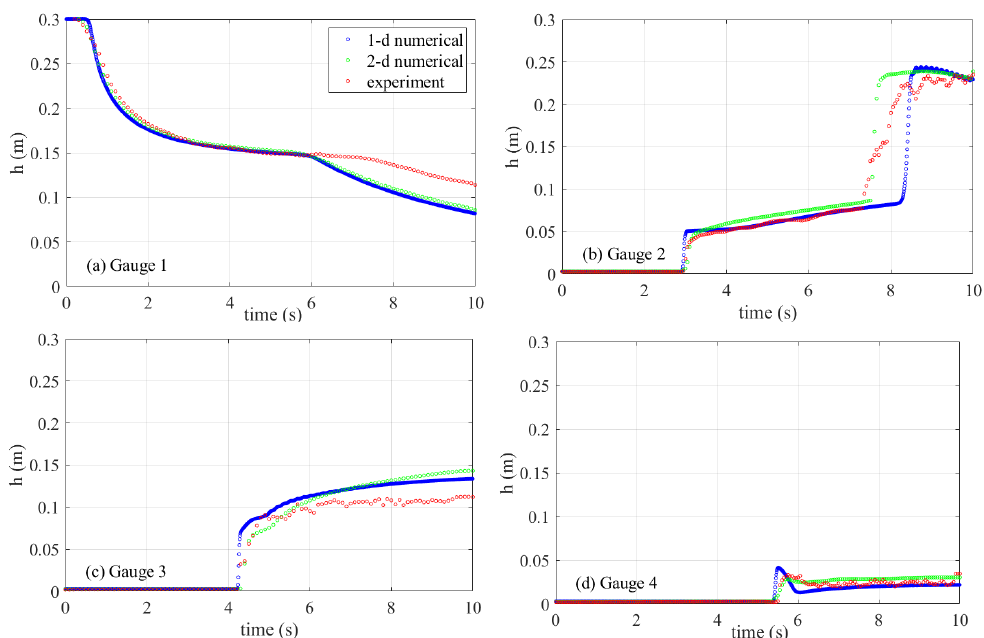
Figure 9. Water levels at four wave gauges, showing the comparison between the MCS-scheme (blue), experiments [3] (red), and 2d-numerical results [17]